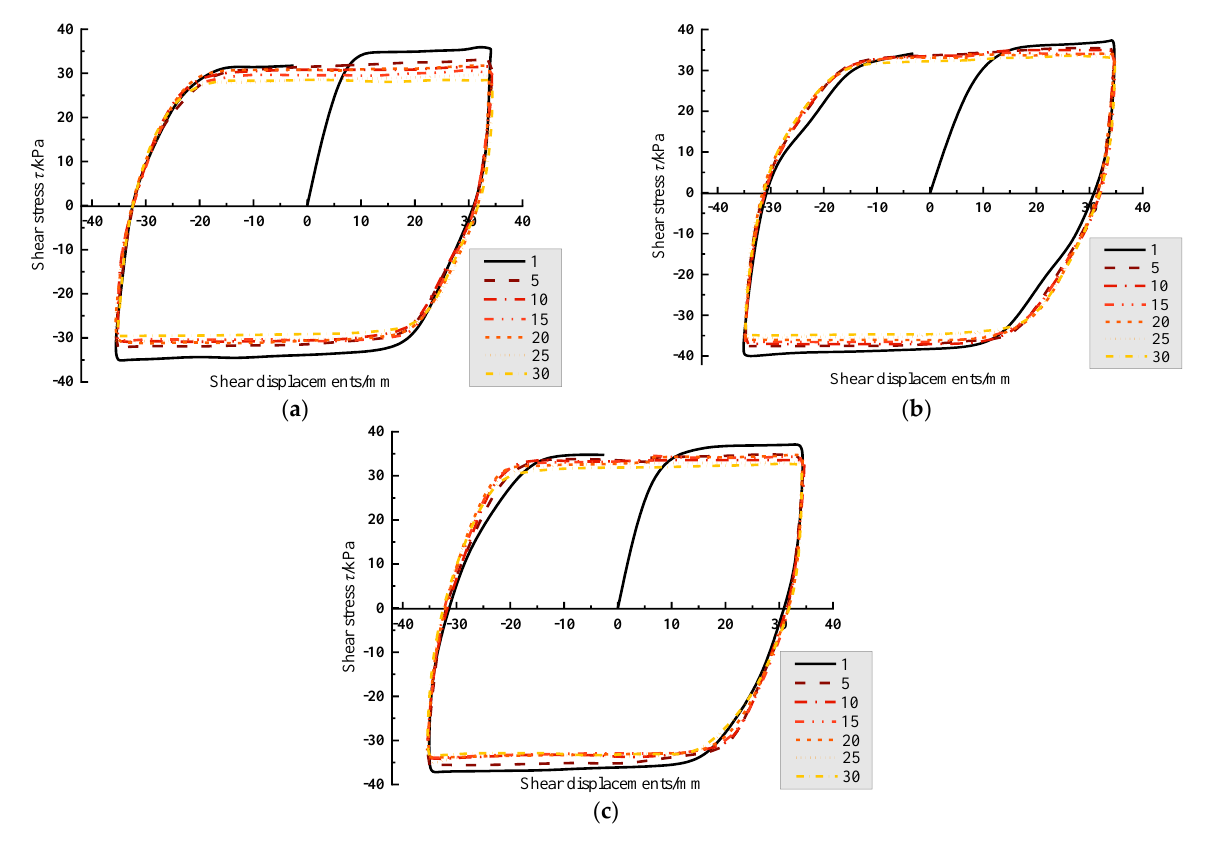
Figure 7. Shear stress-shear displacement curves with different roughness levels: ( a ) R 0 ; ( b ) R 1 ; ( c ) R 2 .